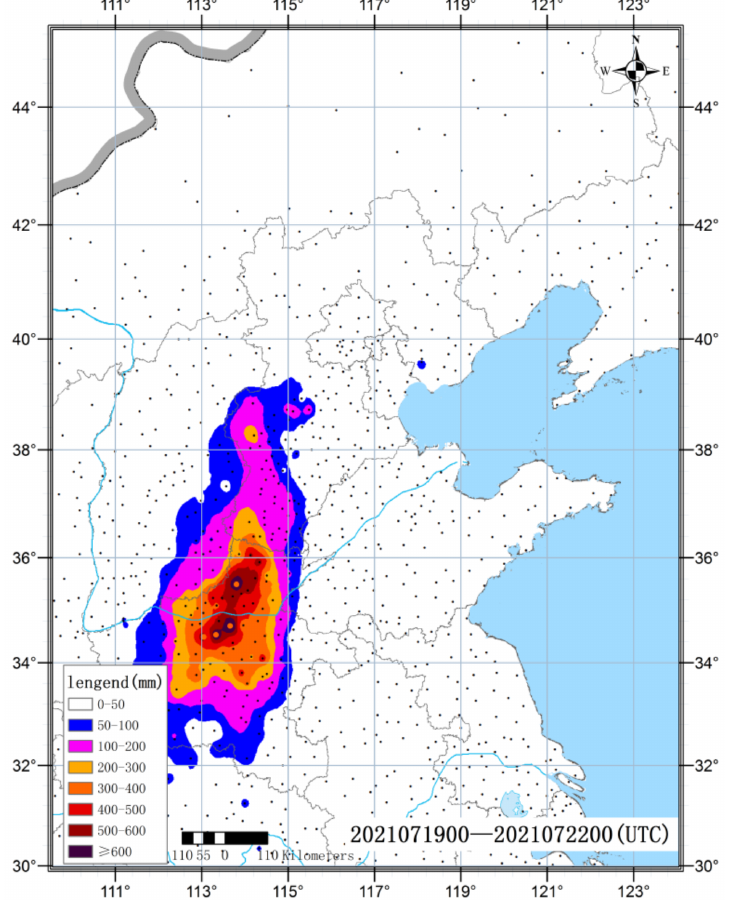
Figure 5. Distribution of observed accumulated rainfall from 19 to 21 July